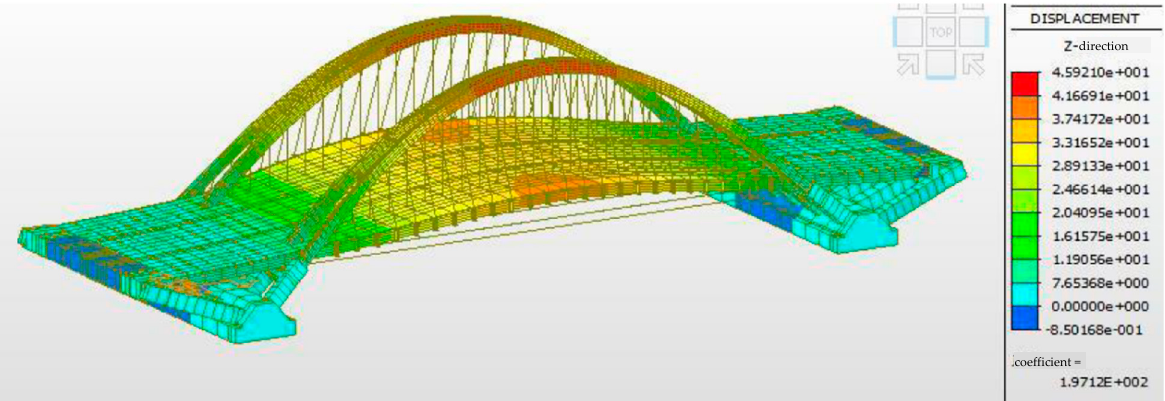
Figure 28. Theoretical deformation of the temperature action of overall heating at 25 °C (unit: mm).